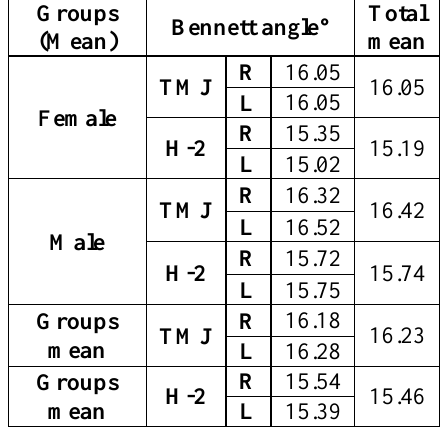
Table 8: Descriptive Statistics of the Detailed Group Mean Values of the Female and Male Patients Concerning the Right and Left Joints' Bennett